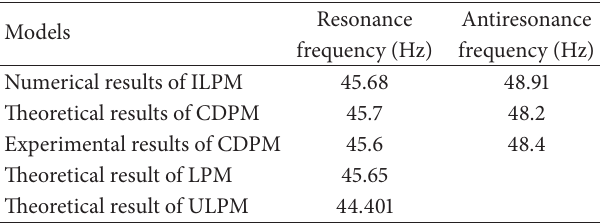
Table 3: Frequencies comparison of ILPM with LPM, ULPM, and CDPM.